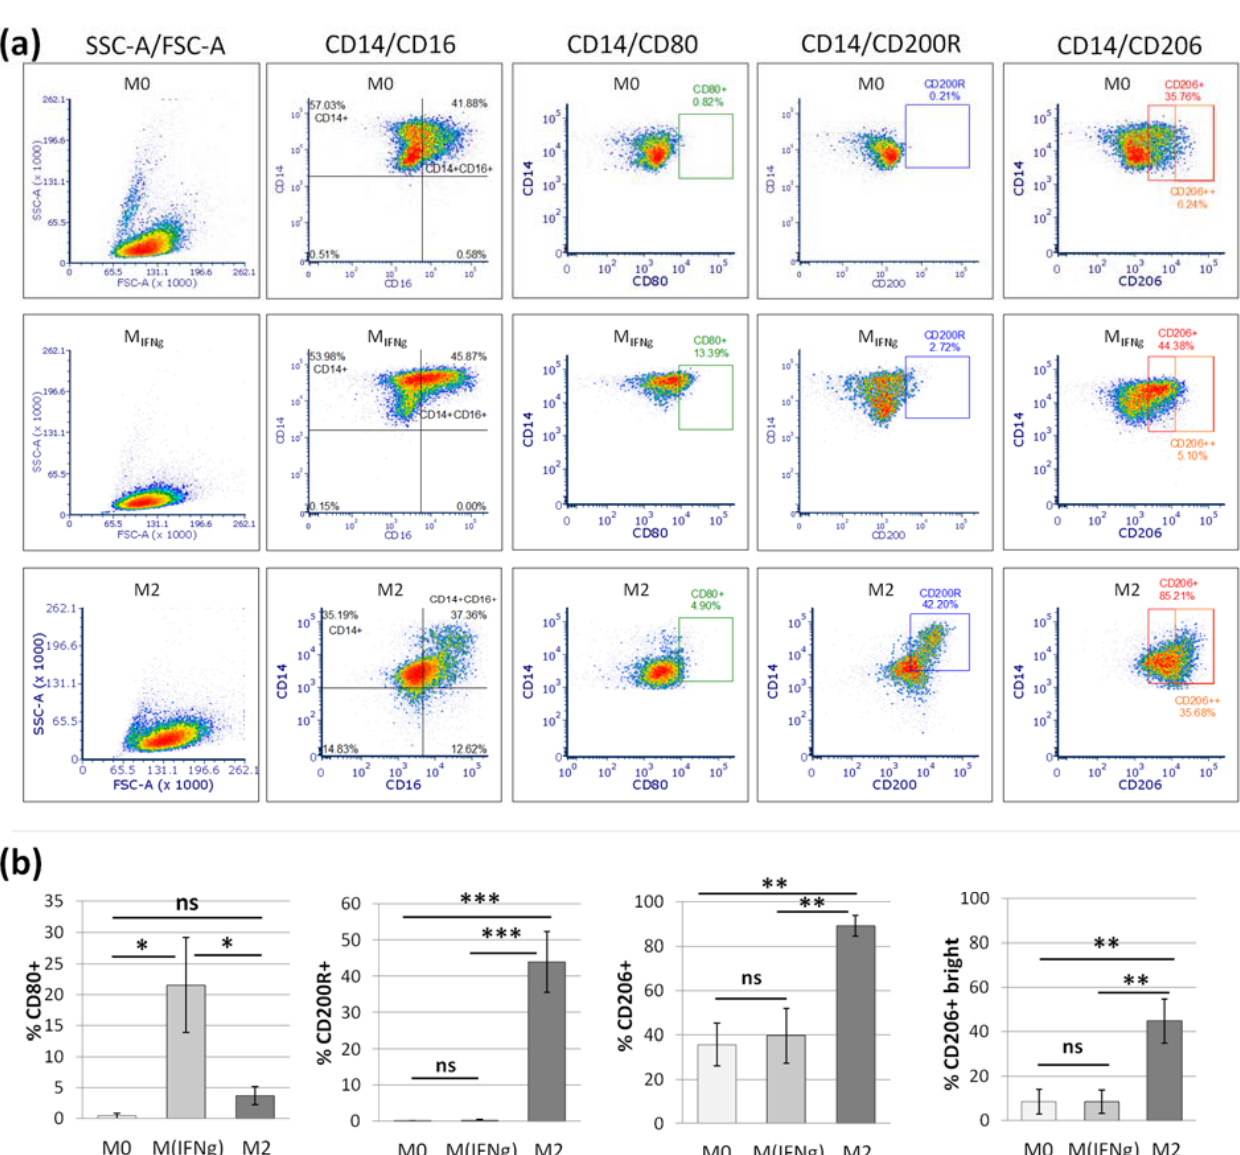
Figure 4. The phenotype of differentially stimulated macrophages. The graph shows the results of the flow cytometry analysis. ( a ) Representative density plots illustrating the expression of different markers on unstimulated (M0), IFN γ stimulated (M IFN γ ) and IL-4/IL-10 stimulated (M2) macrophages. Numbers on the density plots indicate percentage (%) of cells positive for certain markers. ( b ) Bars represent the mean ( ± SEM) expression of markers for different subsets of macrophages. Data analyzed using one-way ANOVA with post-hoc Tukey test. * p < 0.05, ** p < 0.01, *** p < 0.001; ns—statistically not significant; n =